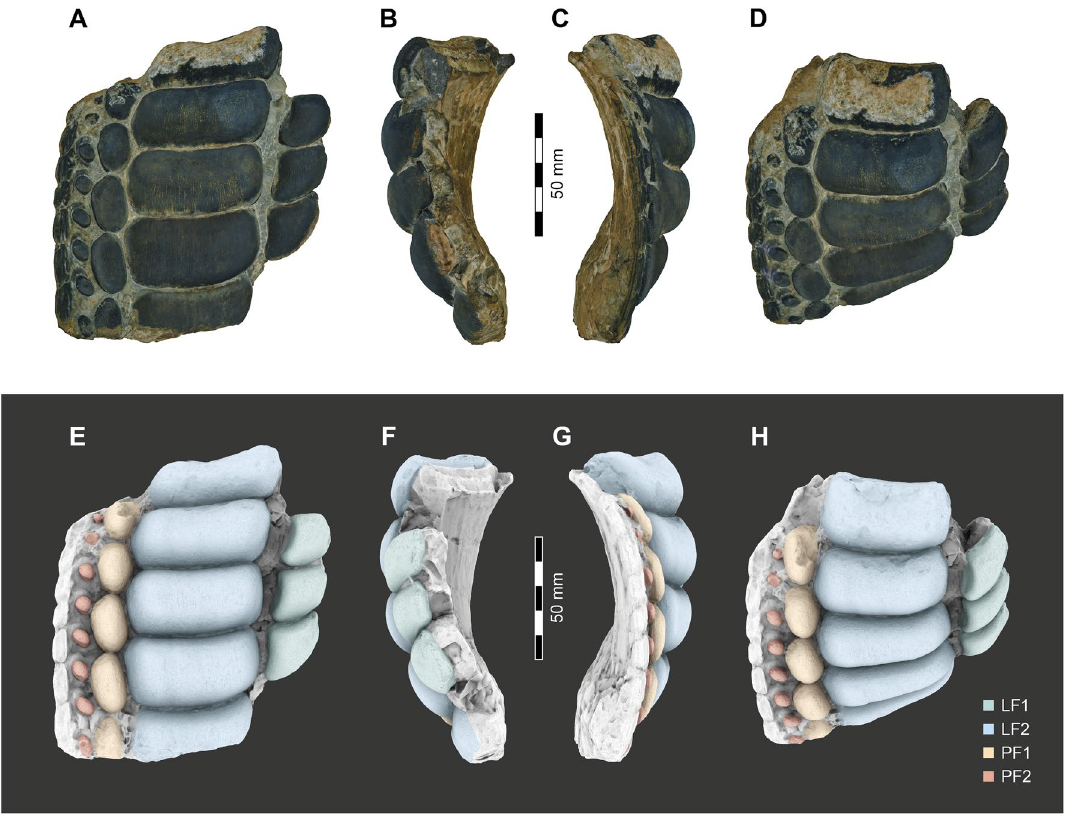
Fig. 2 Strophodus atlasensis sp. nov., PIMUZ A/I 5181, holotype, from the upper Agoudim Formation (Bajocian) near Talsint, Figuig Province, Morocco. Orthophoto ( A – D ) and ambient occlusion photogrammetric model with highlighted tooth crowns ( E – H ) in occlusal ( A , E ), mesial ( B , F ), distal ( C , G ) and oblique occlusal ( D , H ) views. Abbreviations: LF1, tooth crowns of first lateral file; LF2, tooth crowns of second lateral file; PT1, tooth crowns of first posterior file; PT2, tooth crowns of second posterior